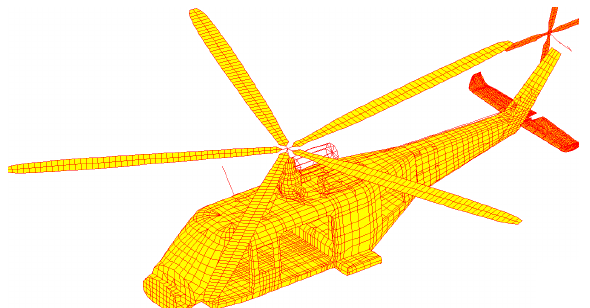
Figure 3. Snapshot of the helicopter